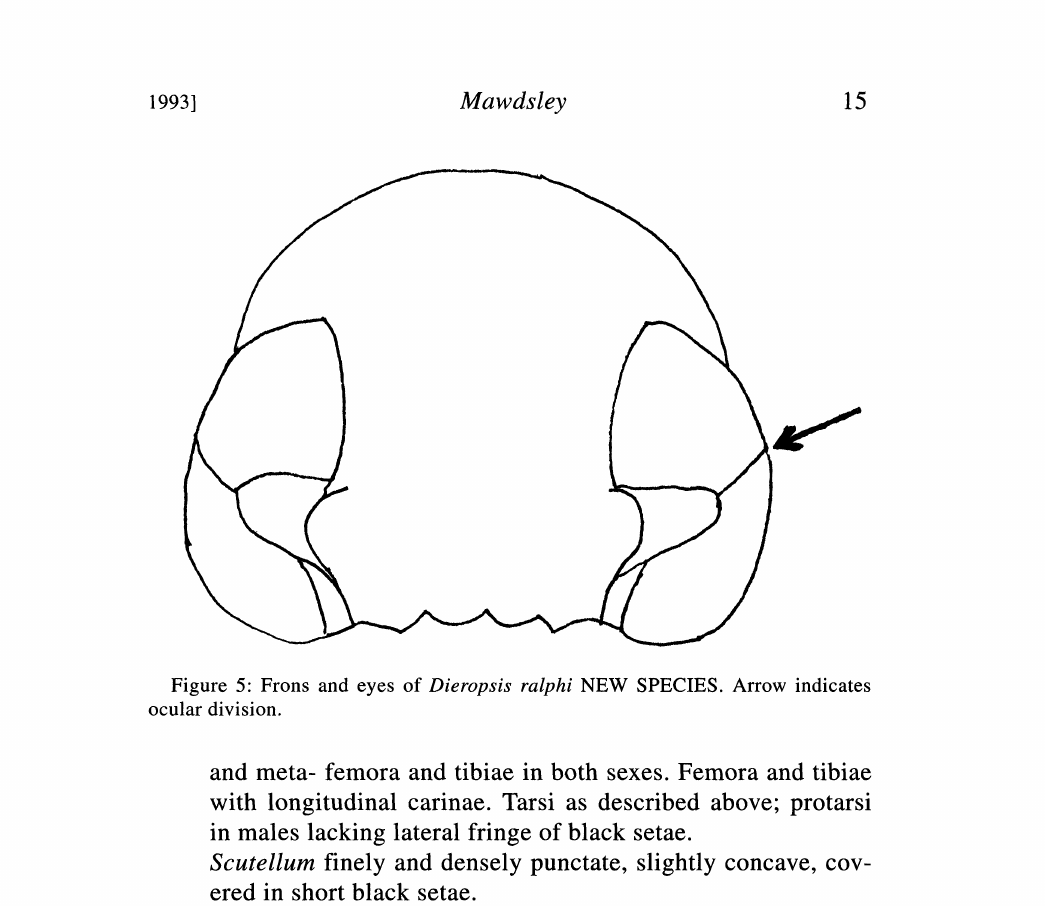
Figure 5: Frons and eyes of Dieropsis ralphi NEW SPECIES. Arrow indicates ocular division. and meta- femora and tibiae in both sexes. Femora and tibiae with longitudinal carinae. Tarsi as described above; protarsi in males lacking lateral fringe of black setae. Scutellum finely and densely punctate, slightly concave, cov- ered in short black